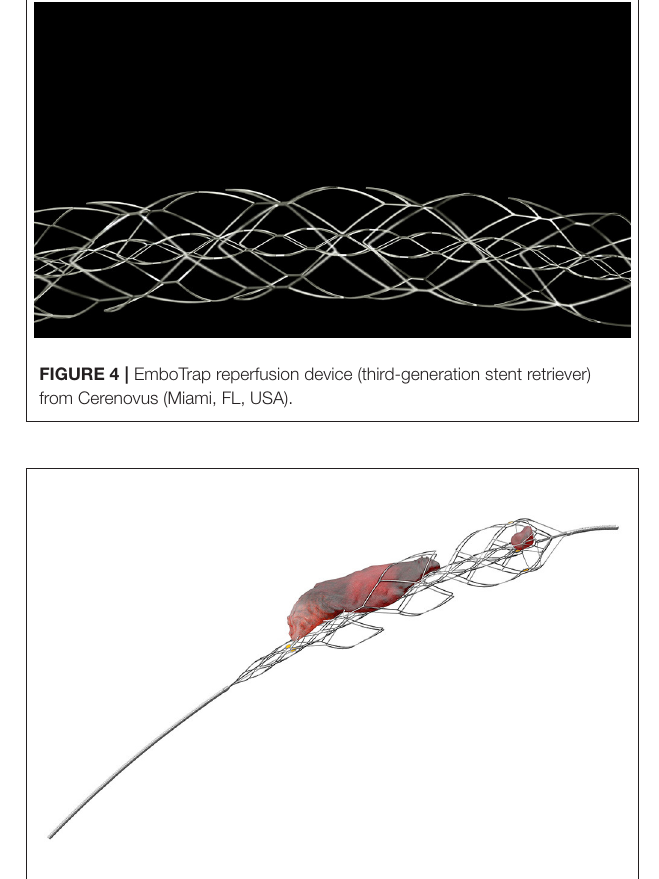
FIGURE 5 | EmboTrap stent retriever shown with a clot in situ